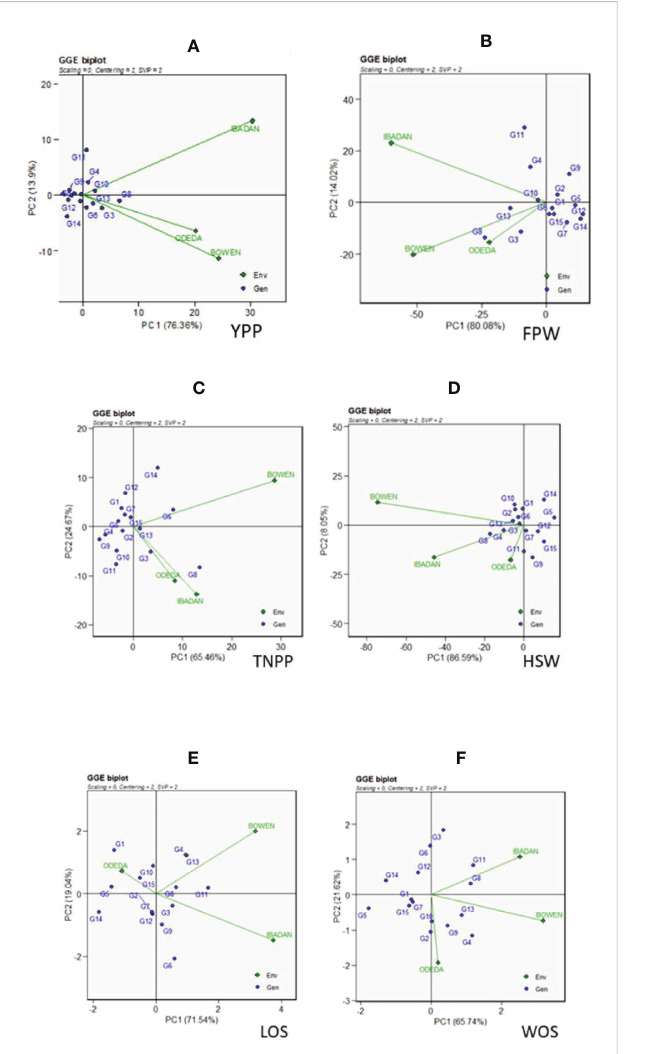
FIGURE 3 Patterns (A – F) . GGE biplots based on PC1 and PC2 showing G × E interactions of the 15 Bambara groundnut accessions under three sites: (A) yield per plant (YPP), (B) fresh pod weight (FPW), (C) total no. of pods per plant (TNPP), (D) hundred seed weight (HSW), (E) length of seeds (LOS), and (F) width of seeds (WOS). The GGE biplots were based on scaling = 0, centering = 2, and singular value partitioning (SVP) = 2.